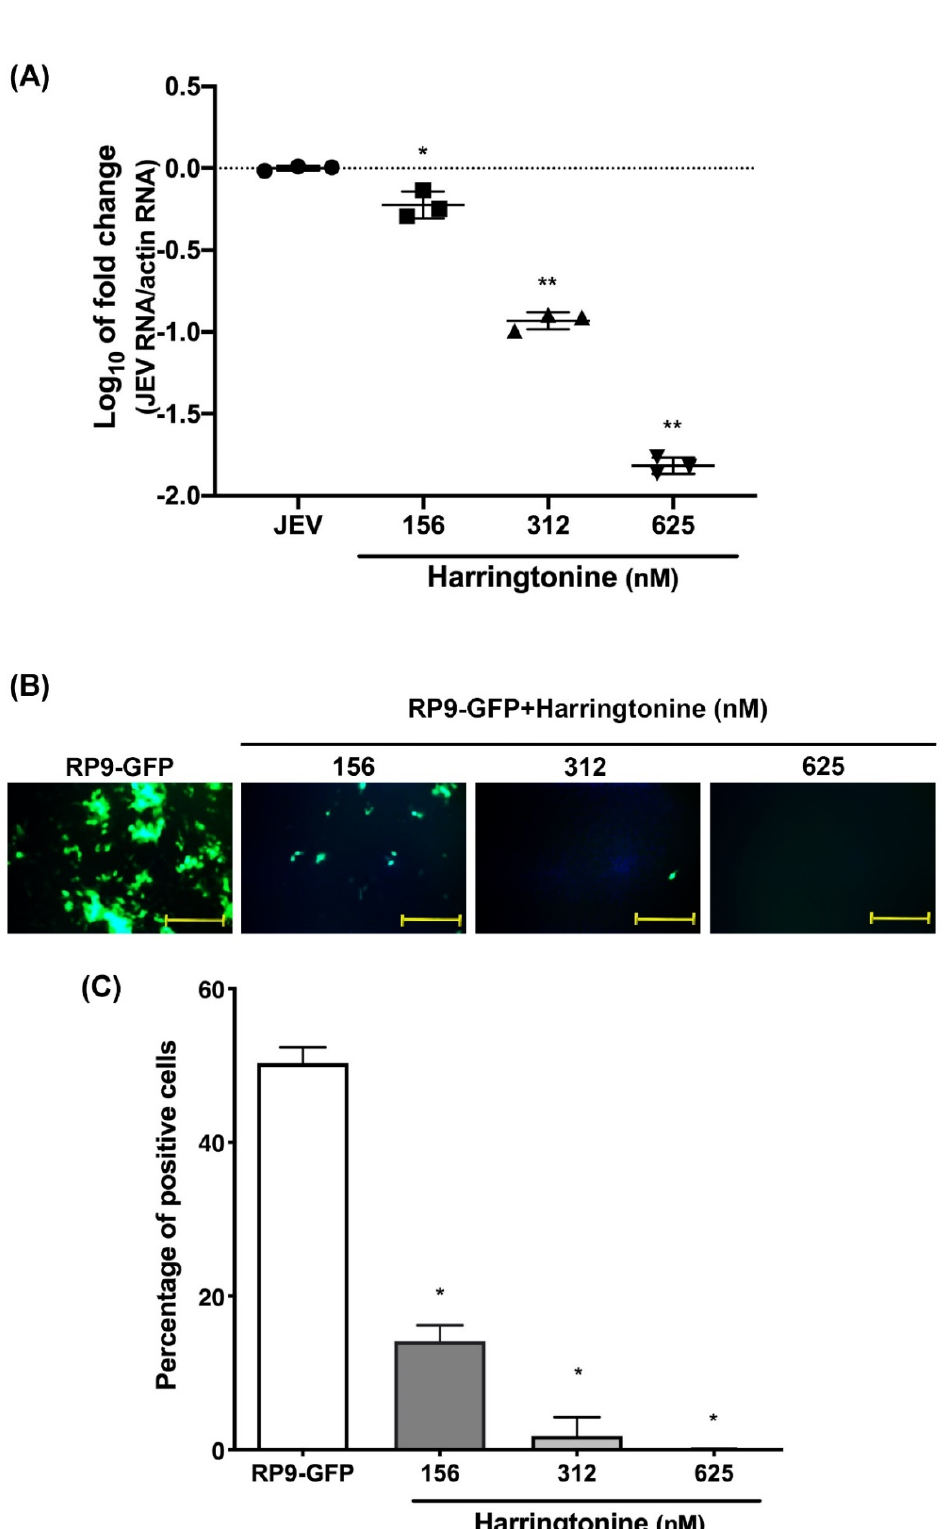
Figure 5. Inhibitory activities of harringtonine against Japan encephalitis virus. Vero cells were infected with (RP9-GFP) and were treated with different concentrations of harringtonine for 48 h. The viral RNA levels were determined using RT-qPCR ( A ). The inhibitory effects on viral fluorescent protein expression were observed under an inverted fluorescence microscope ( B ). Quantification of Vero cells ( C ). Statistical significance was analyzed from t -test compared with the JEV or PR9-GFP groups: * p < 0.05; ** p < 0.01. Scale bar: 50 μ m.